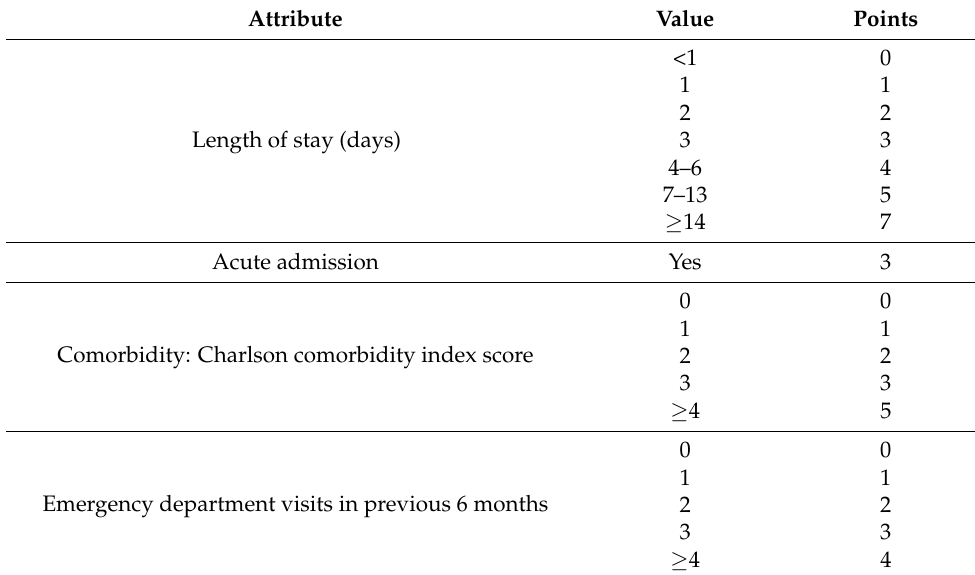
Table A1. Components of LACE score [19].